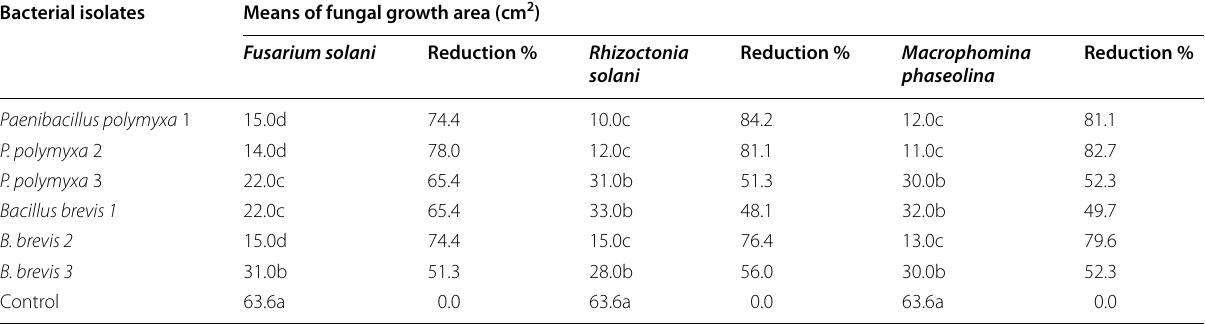
*Means in a column followed by the same letter are not significantly ( P